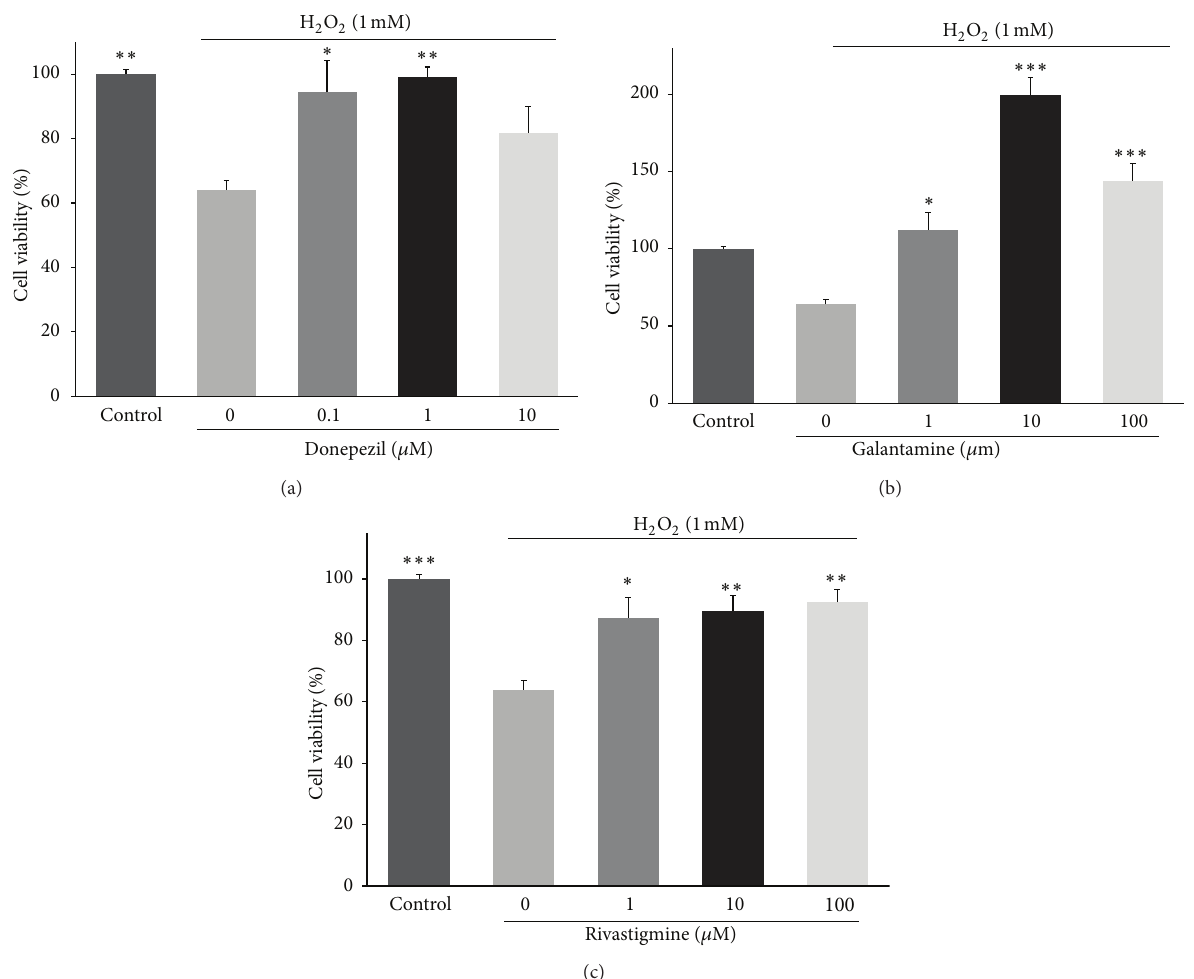
Figure 1: Effects of AChE inhibitors on viability of endothelial cells in the presence of H 2 O 2 . The HUVECs were seeded overnight in 96-well culture plate (5000 cells/well) and treated with donepezil, rivastigmine, and galantamine for 24h. The percent of viability was normalized against untreated control cells. Data are mean ± SD of two independent experiments performed in triplicate. ∗ 𝑃 < 0.05 , ∗∗ 𝑃 < 0.01 , and ∗∗∗ 𝑃 < 0.001 versus untreated cells cultured in the presence of H 2 O 2